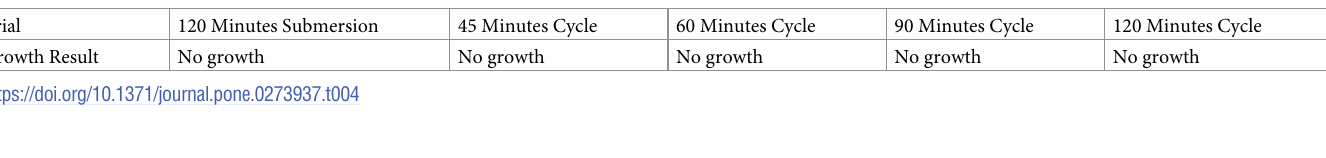
Table 4. BI growth at 7 days following exposure to 3% H 2 O 2 solution.